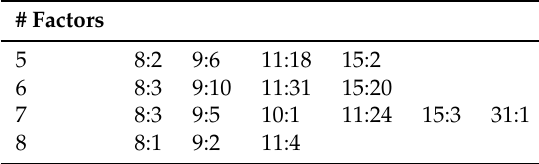
Table 7. Factor distribution of idempotent factorizations < 2 30 ( ≥ 8